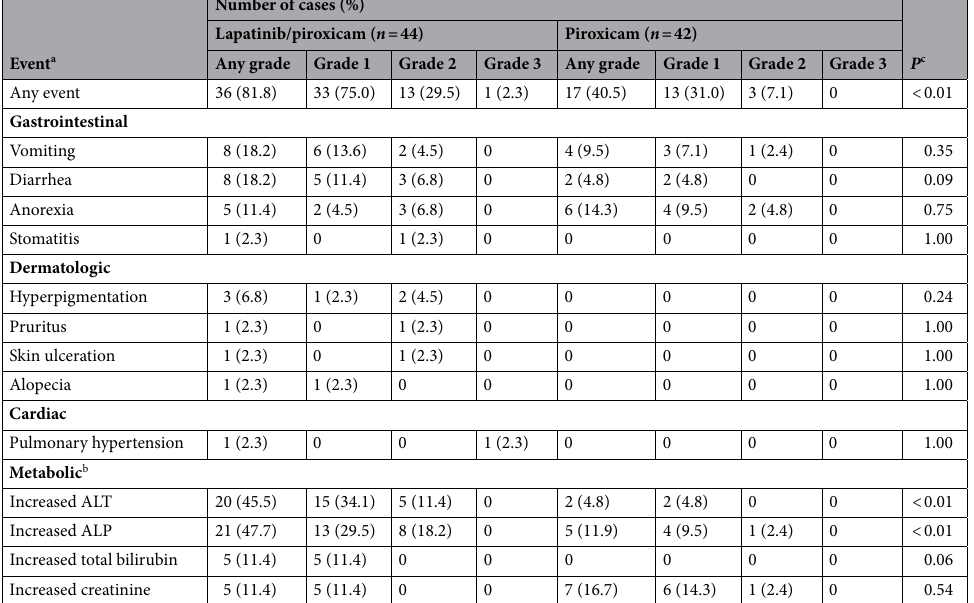
Table 2. Adverse events in dogs treated with lapatinib/piroxicam or piroxicam alone. a Toxicity grade based on